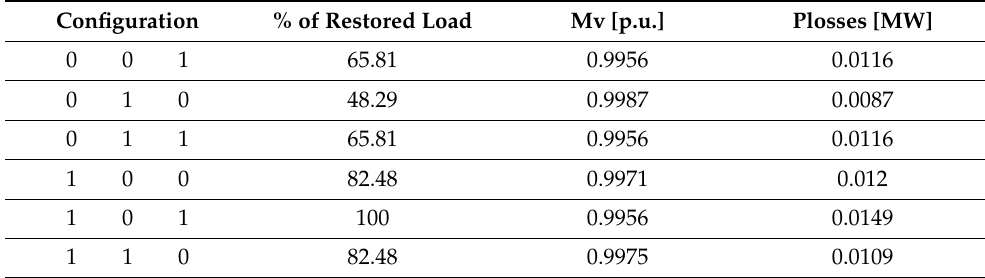
Table 7. Performance indicators for different counterfeed configurations in case of the outage of branches D41-D42 and